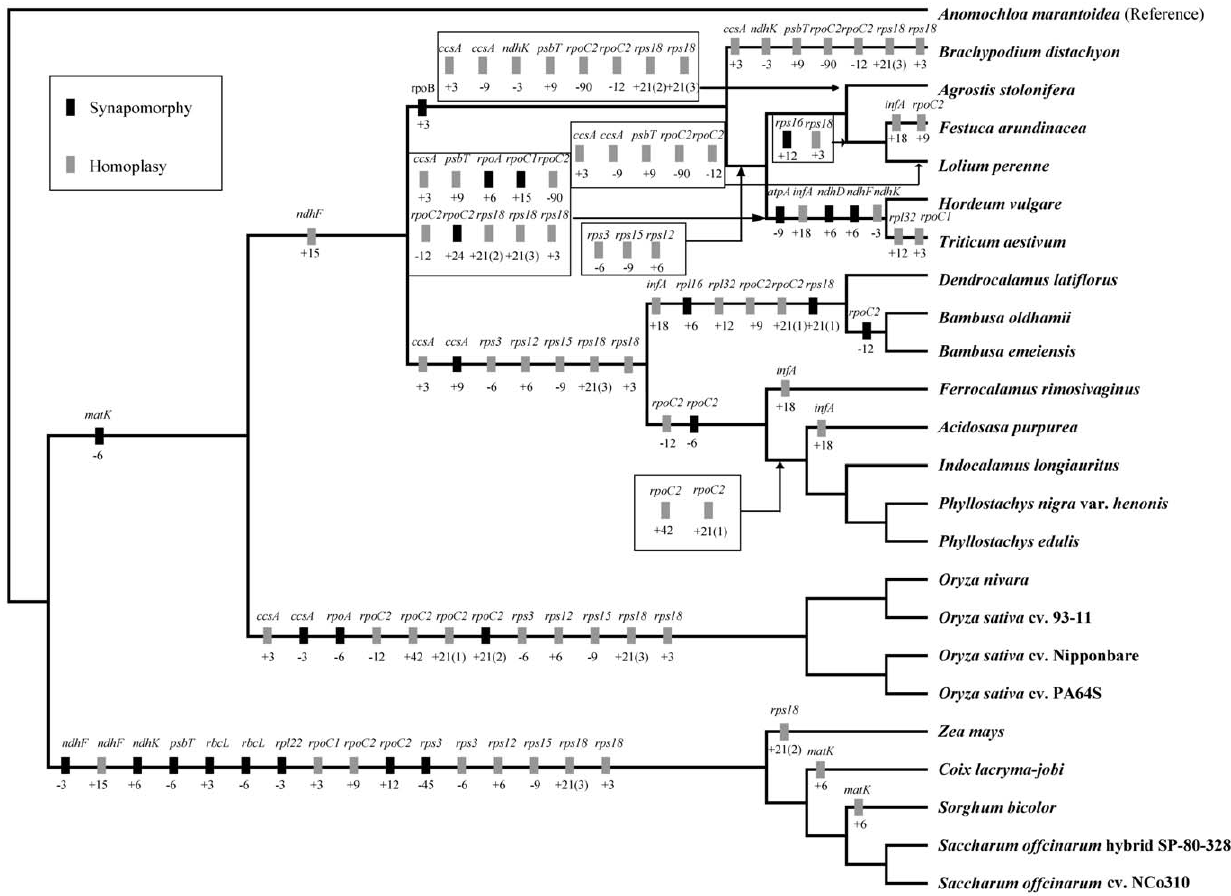
Figure 7. Phylogenetic distribution of exon coding indels in sampled grass accessions. Gene names are given above boxes and sizes of indels (bp) and polarity (‘ + ’ = insertion, ‘ 2 ’=deletion) are given below boxes. Polarity of mutations was determined by comparison to outgroup Anomochloa marantoidea . Tree topology was based on maximum parsimony analysis of complete chloroplast genomes.